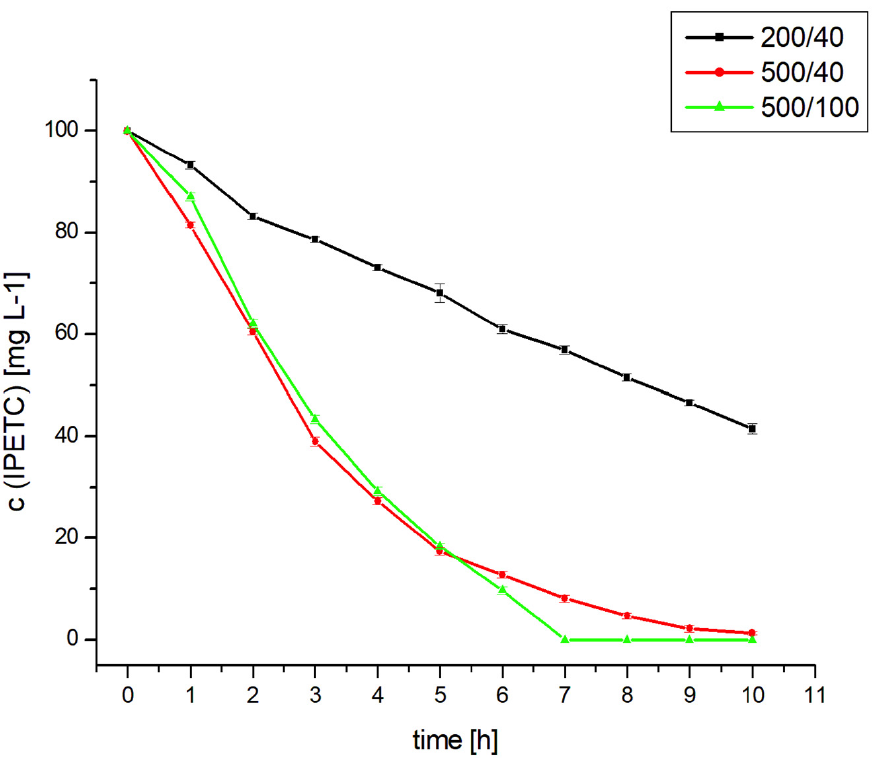
Figure 2. Decomposition of IPETC in FeCl 3 /H 2 O 2 system. Numbers in the legend represent conc. of H 2 O 2 and Fe in ppm.